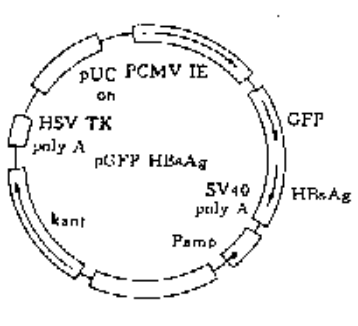
Figure 1. The structure of pGFP-HBsAg